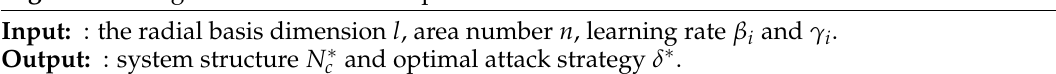
Algorithm 1 Algorithm of Structure Optimization under DoS